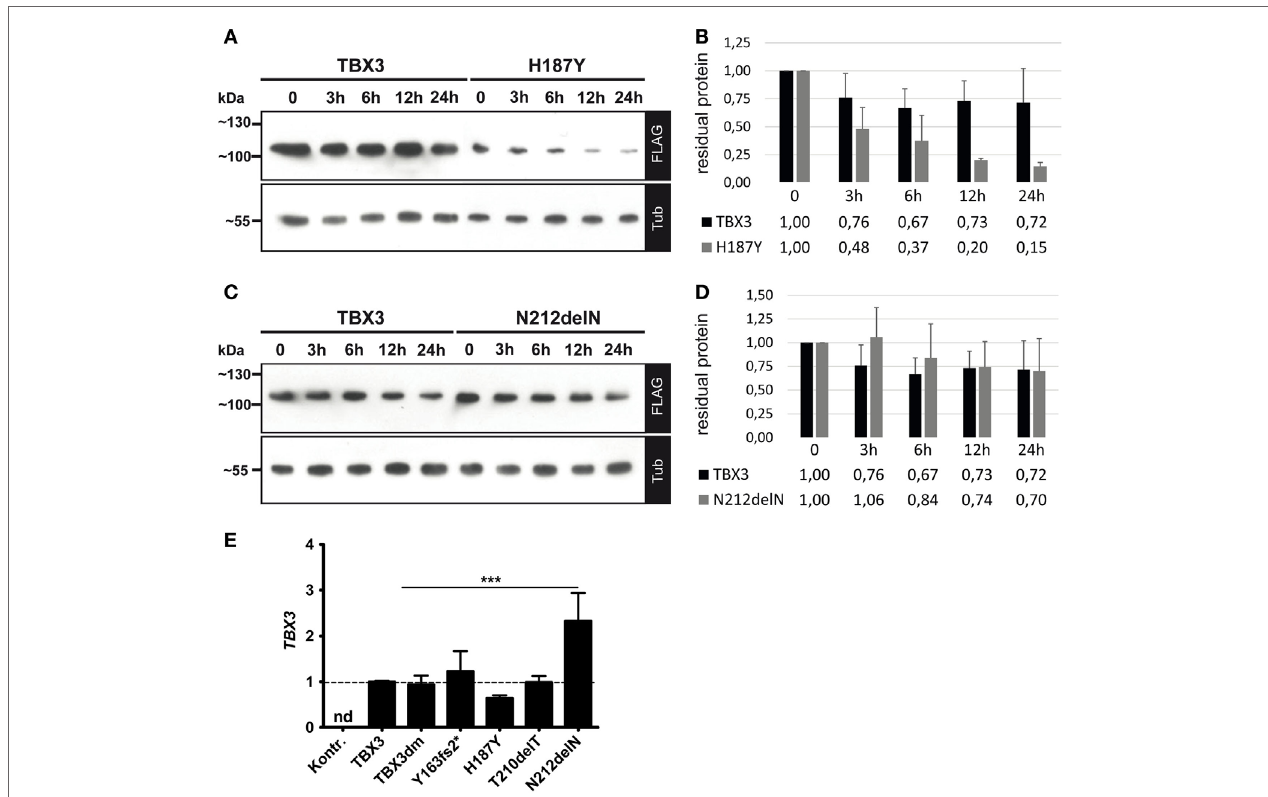
FigUre 6 | Protein stability and transcript abundance of TBX3 and mutant derivatives . COS-7 cells were transfected with 50 ng of expression vector encoding TBX3 or its mutants. Twenty-four hours after transfection cycloheximide (CHX) was added to 25 μ g/ml. Cells were lysed at the indicated time points. Protein level was quantified by Western blot of cell extract and FLAG bioluminescence immunodetection. Protein load was controlled with anti-alpha-tubulin. (a,B) TBX3 and H187Y, (c,D) TBX3 and N212delN. (e) Quantification of TBX3 transcript levels by real time qPCR. COS-7 cells were transfected with 25 ng of expression vector encoding TBX3 or its mutants (the empty vector was transfected in the control experiment). RNA was isolated 48 h after transfection and analyzed. The data are normalized to TBX3. No TBX3 transcription was detected (nd) in cells transfected with empty vector. The higher level of N212delN RNA relative to normal TBX3 was statistically significant ( n =